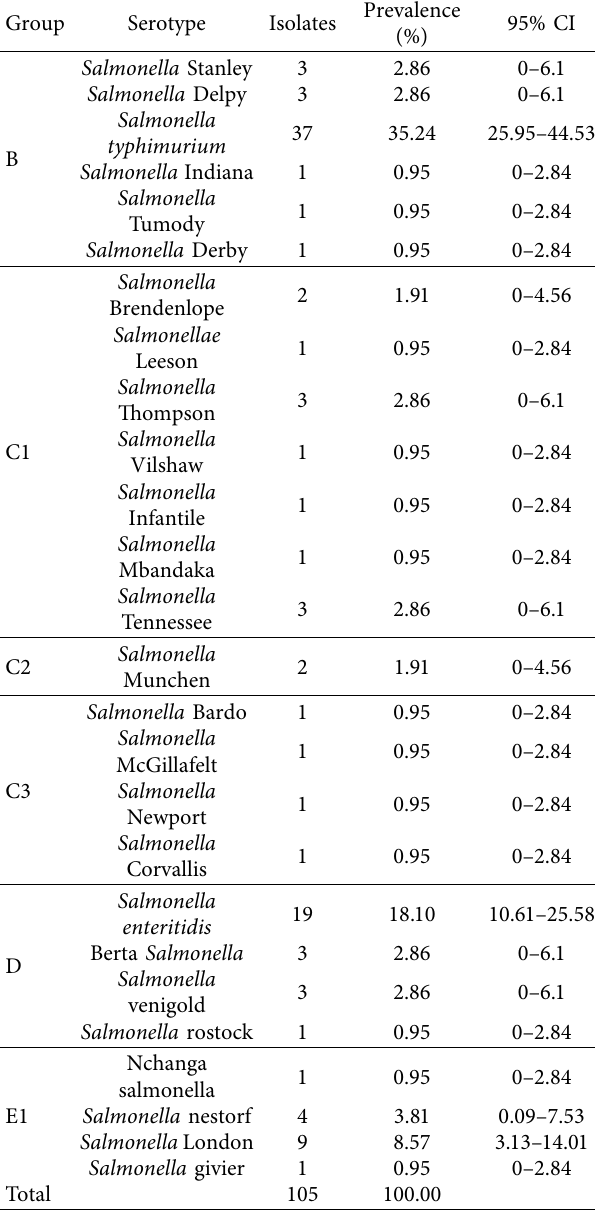
Table 2: Antimicrobial susceptibility of Salmonella strains ( n � 105) collected from 2018 to 2020 in six sentinel hospitals from Huzhou, Zhejiang, China.